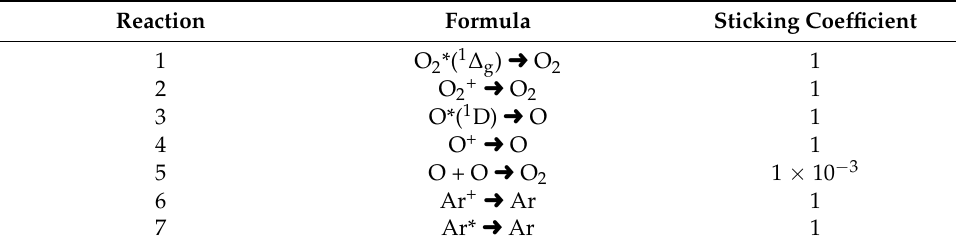
Table 5. Surface